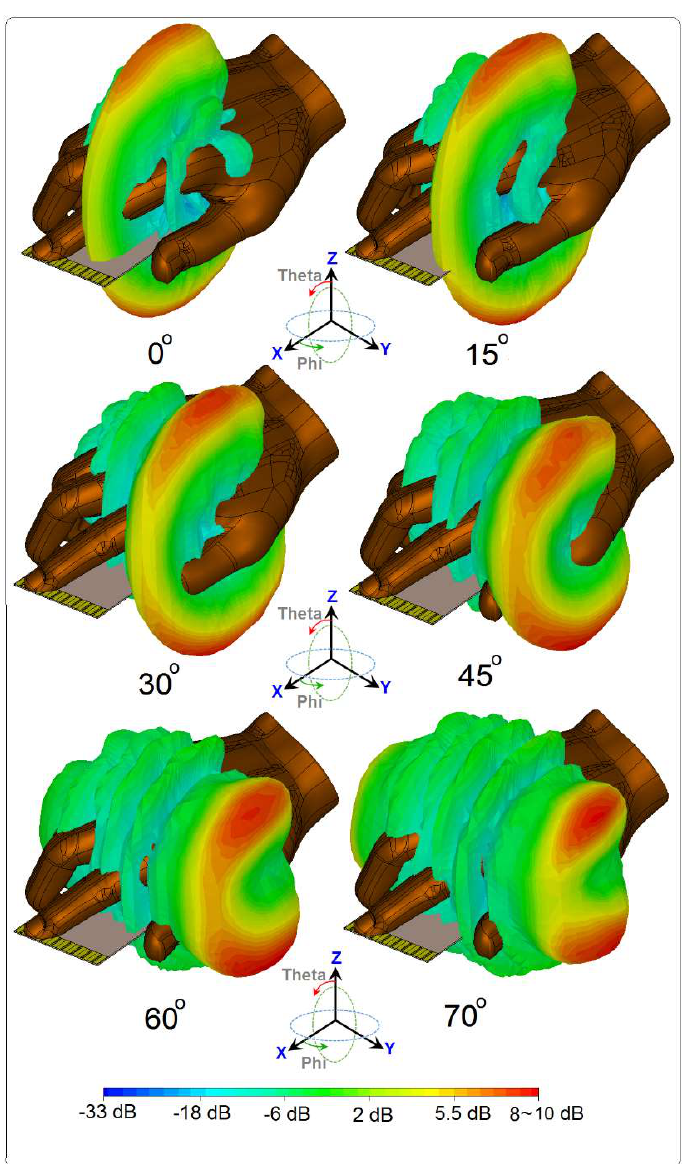
Figure 22. Three-dimensional beams of the array radiation in Data-Mode.